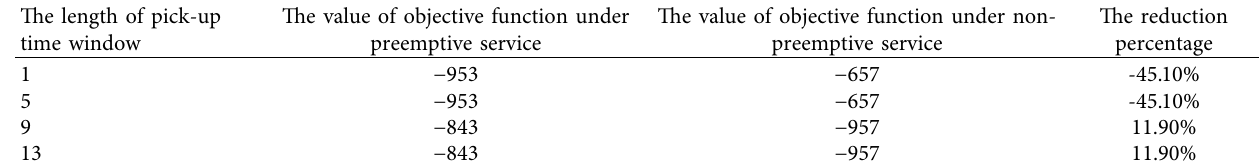
Table 16: The solution results under different lengths of pick-up time